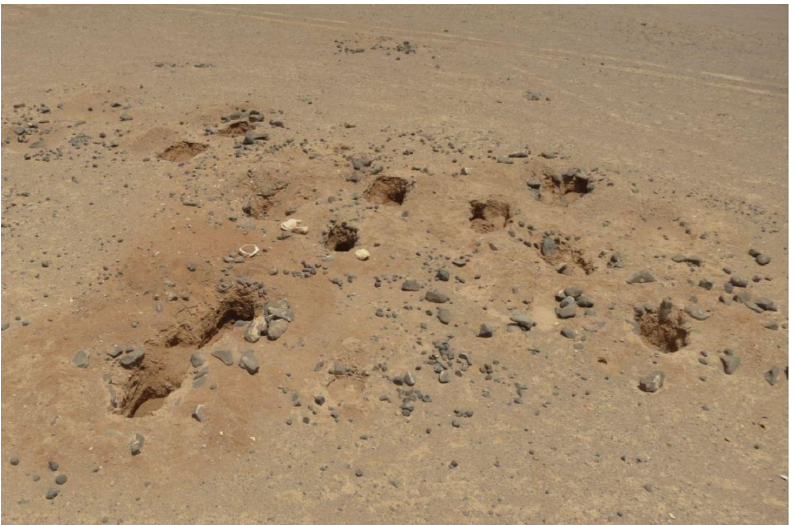
Figure 15. Oblique terrestrial documentation of recent looting near M9, recorded with a pole aerial photography (PAP)